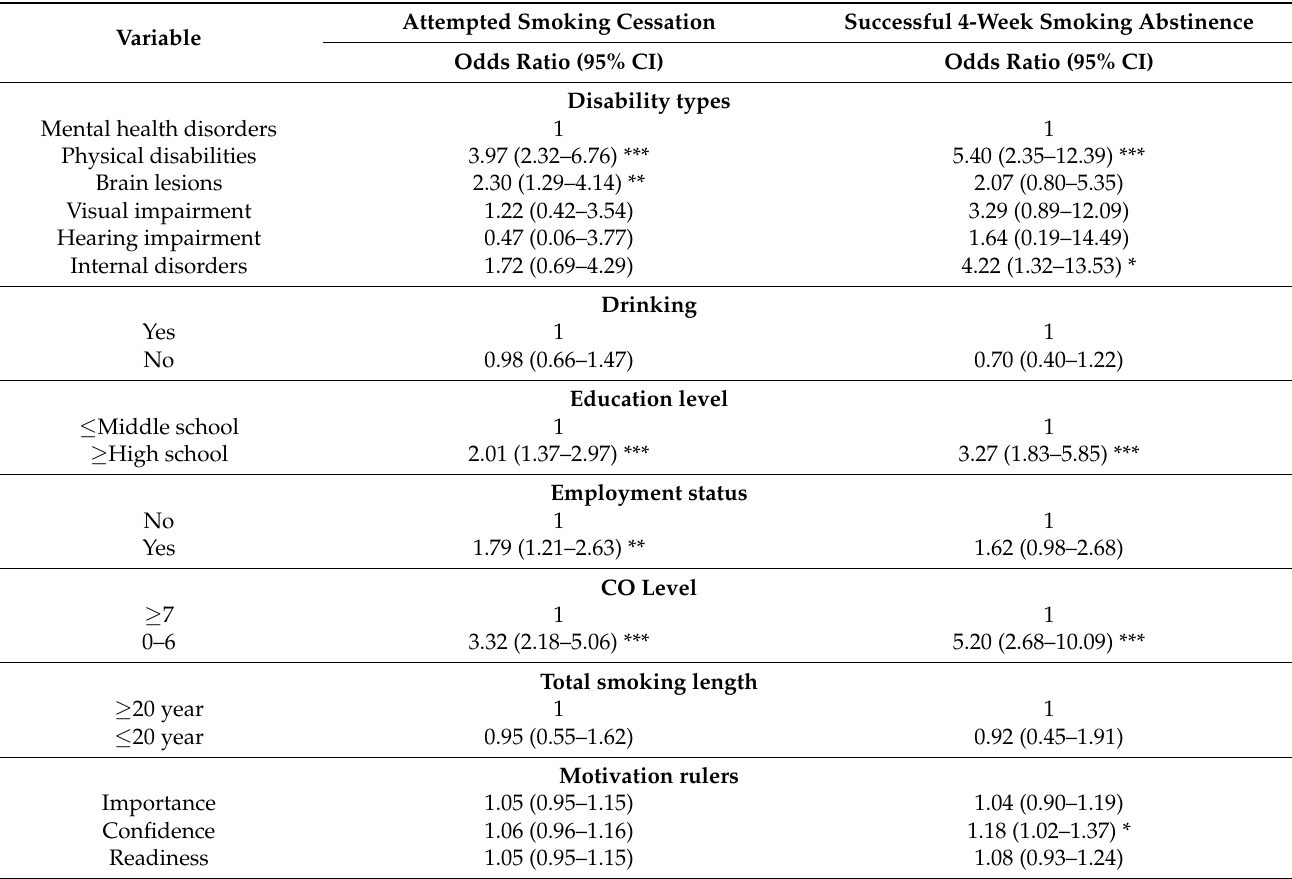
Table 4. The factors associated with attempted smoking cessation and successful four-week smoking